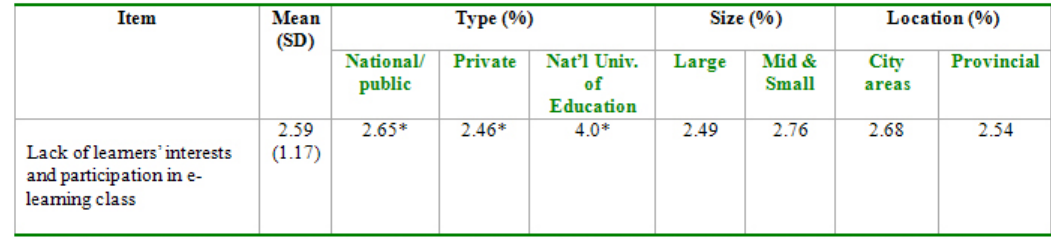
Table 7. Awareness on Learners’ Interests and